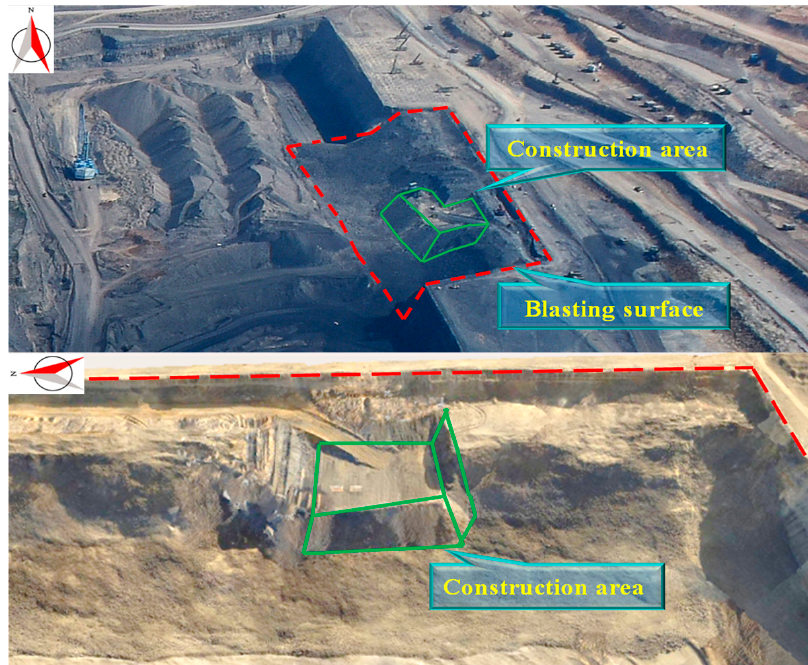
Figure 4. DSM model of cast blasting stockpile.